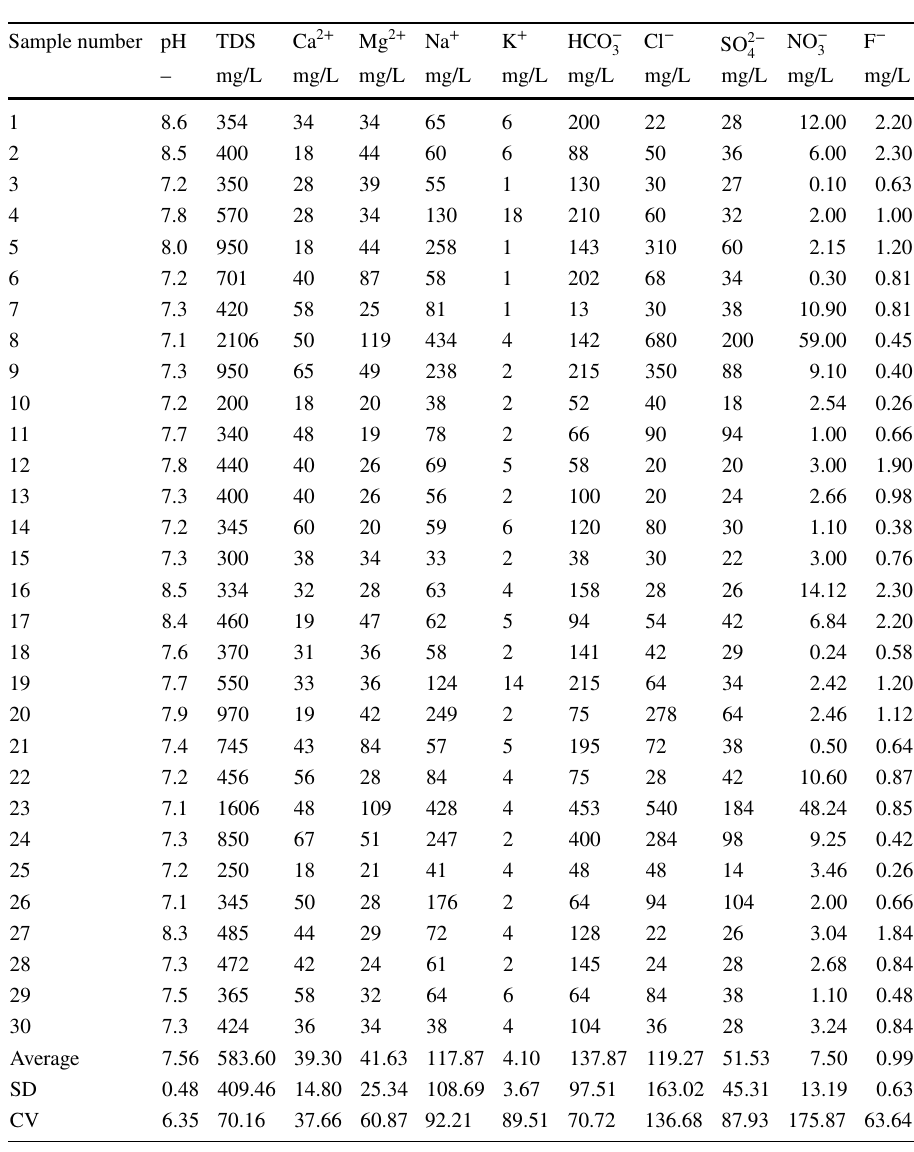
Table 3 Chemical composition of groundwater